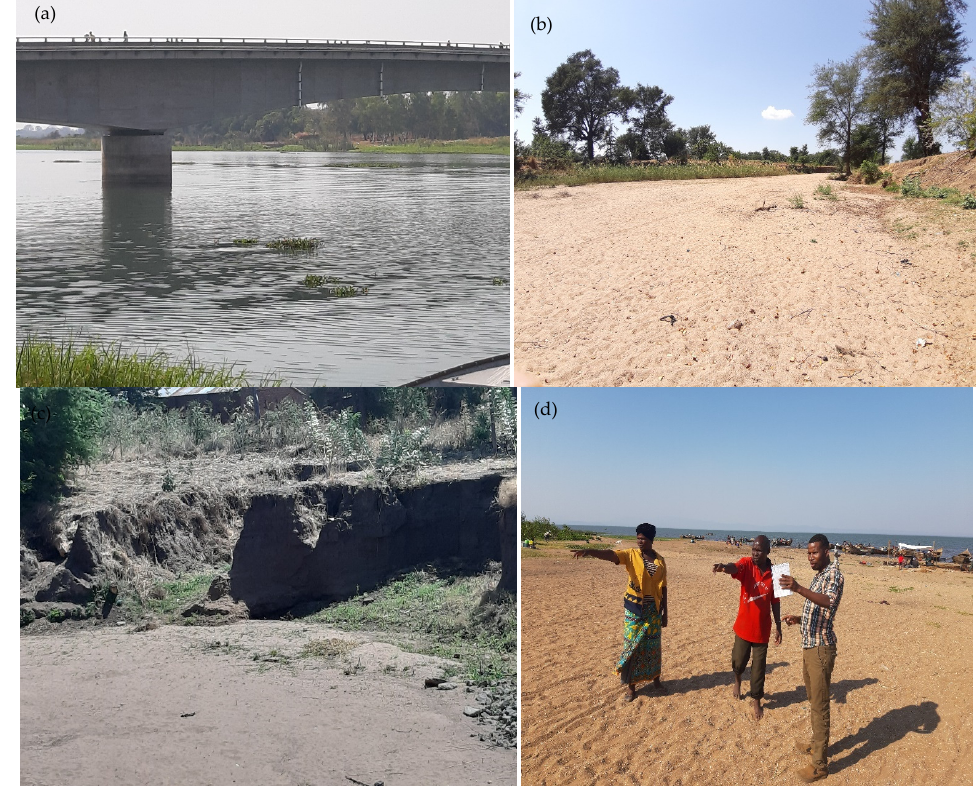
Figure 11. The current state of the Lake Malombe ecosystem.